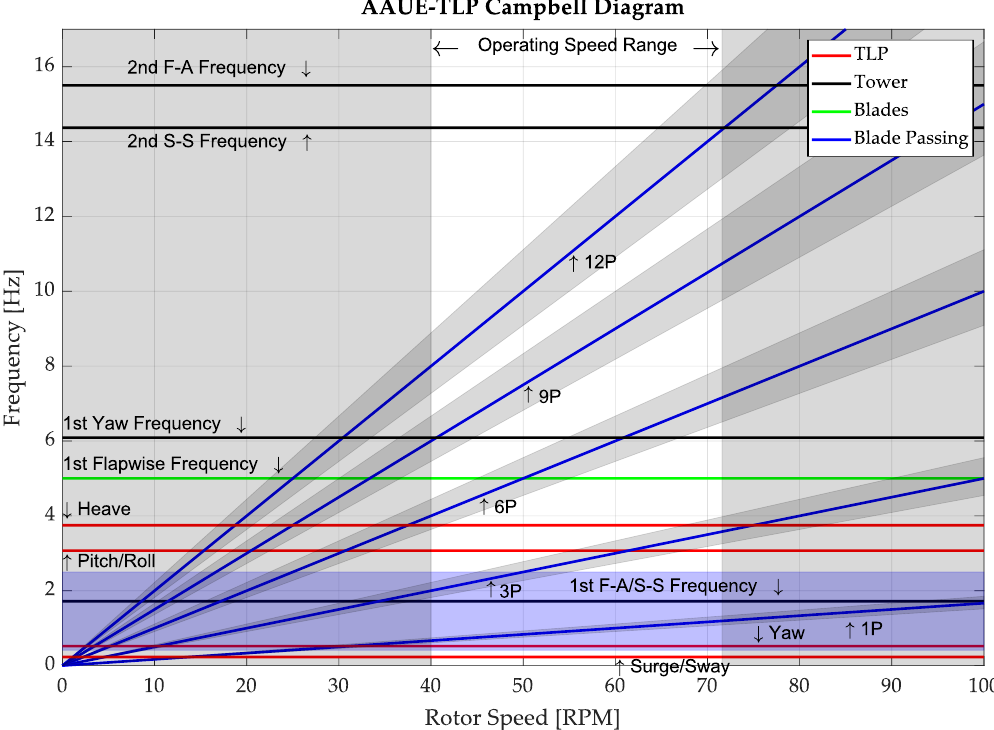
Figure 5. Campbell diagram for the AAUE-TLP. The blue shaded area is the wave loading frequency interval from a JONSWAP